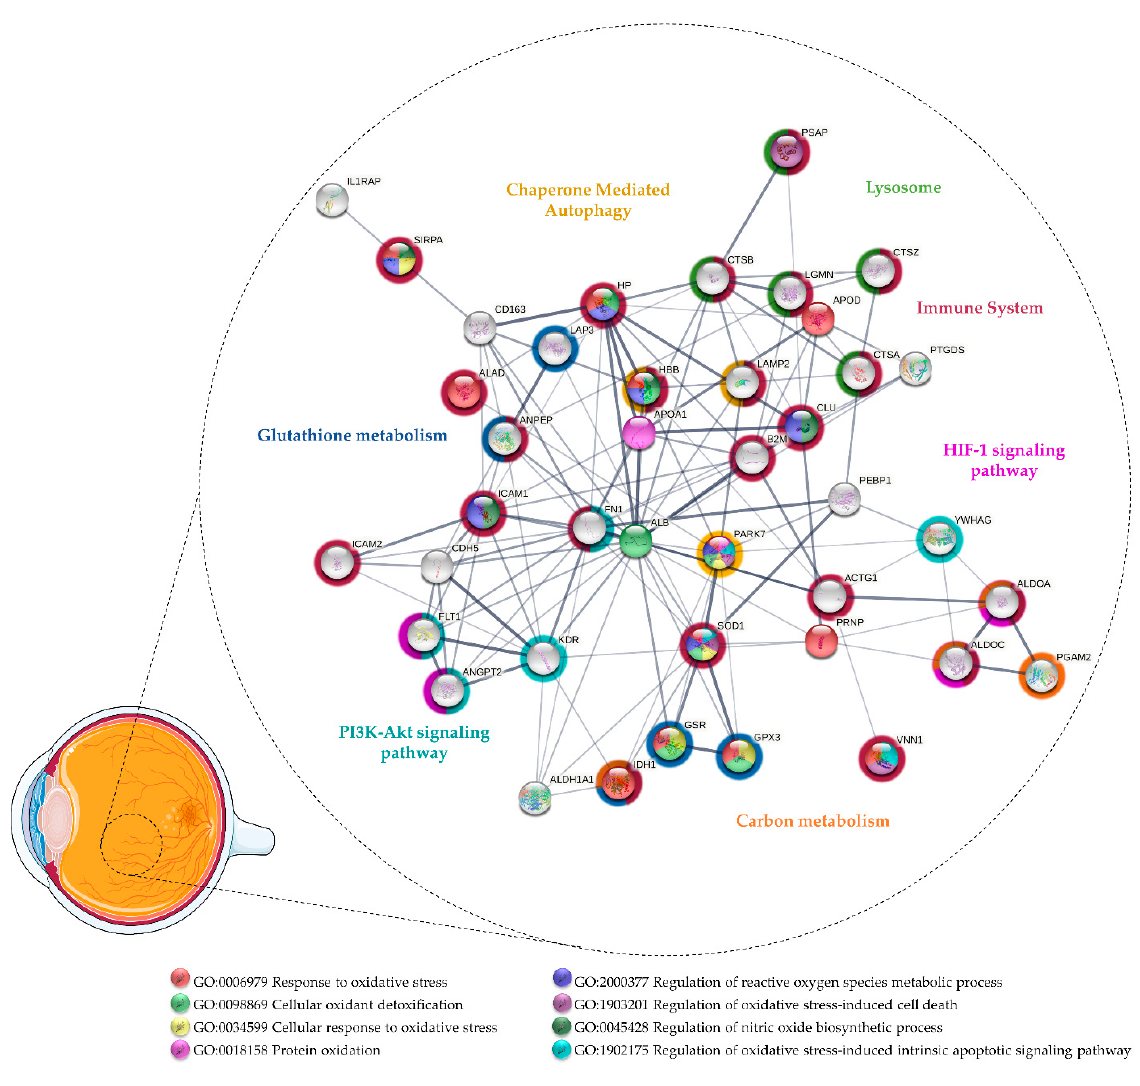
Figure 2. Protein–protein interaction network of the proteins related to oxidative stress found differentially expressed in vitreous collected from patients with age-related macular degeneration. The network was predicted using STRING 11.5 based on medium confidence